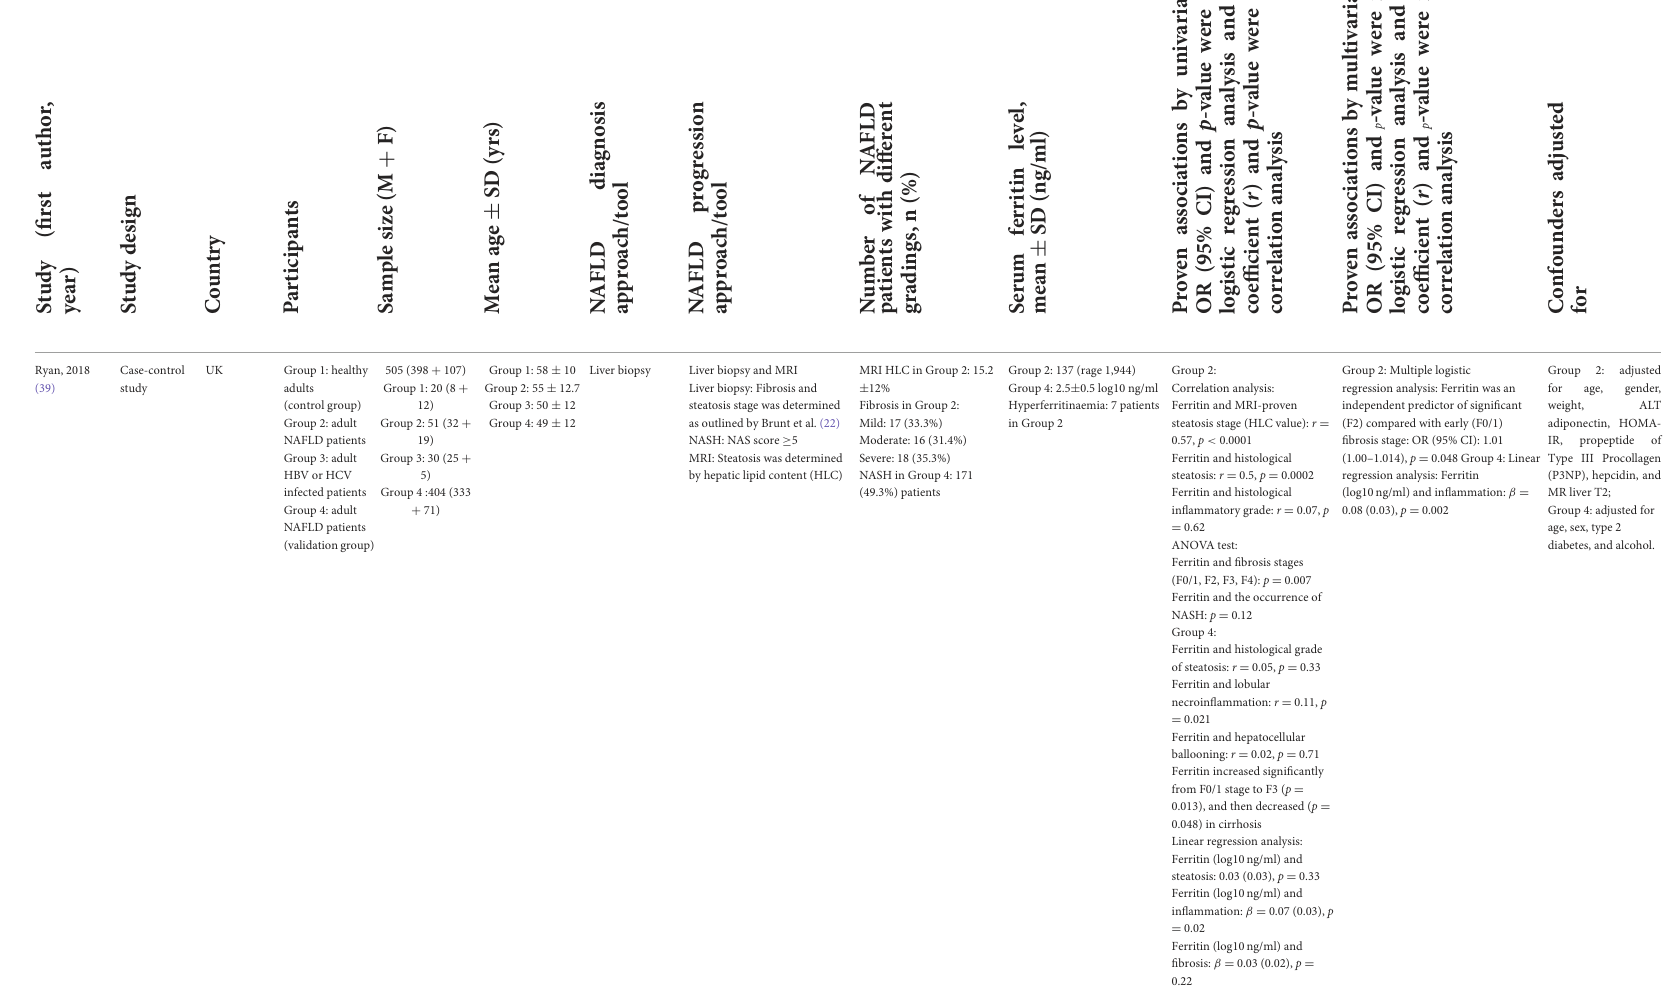
Group2:Multiplelogistic regressionanalysis:Ferritinwasan independentpredictorofsignificant (F2)comparedwithearly(F0/1) fibrosisstage:OR(95%CI):1.01 (1.00–1.014), p = 0.048Group4:Linear regressionanalysis:Ferritin (log10ng/ml)andinflammation: β = 0.08(0.03), p = 0.002